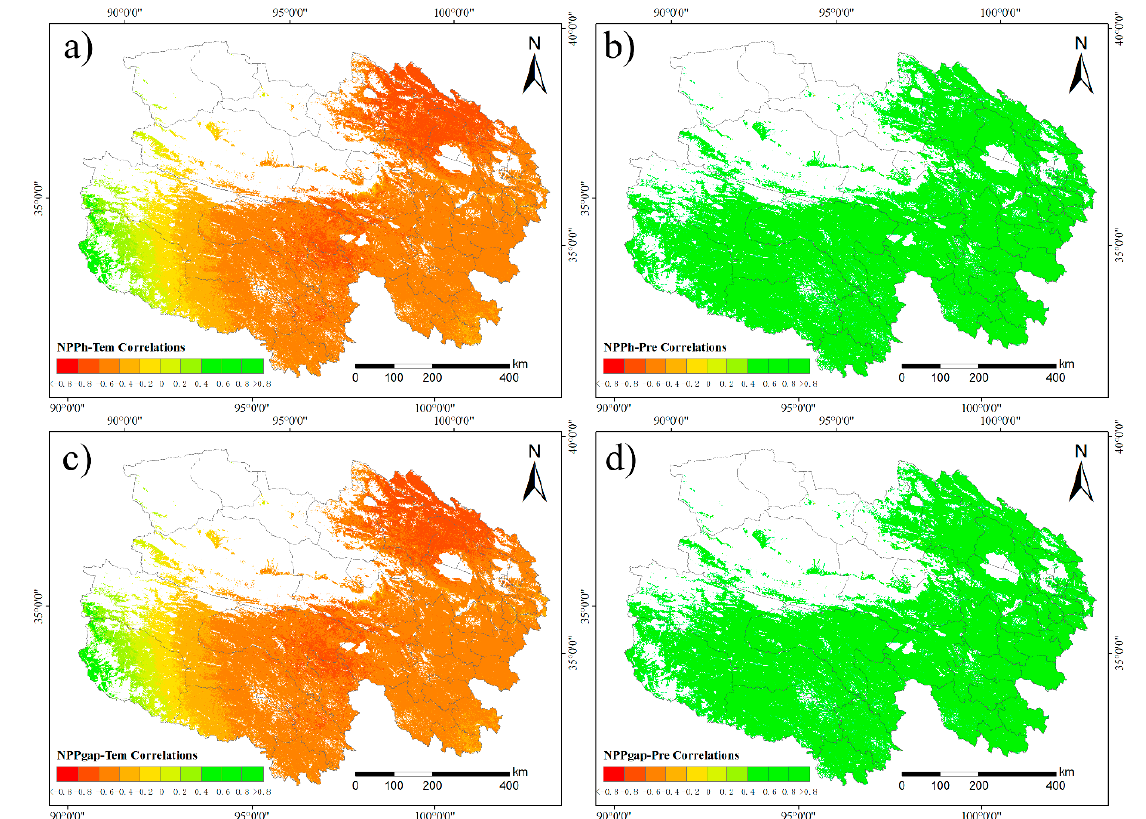
Figure 7. Correlations of NPP h and NPP gap with climate in alpine grassland in Qinghai Province from 2005 to 2018: ( a ) correlation coefficient between NPP h and temperature; ( b ) correlation coeffi- cient between NPP h and precipitation; ( c ) correlation coefficient between NPP gap and temperature; ( d ) correlation coefficient between NPP (cid:2917)(cid:2911)(cid:2926) and precipitation.